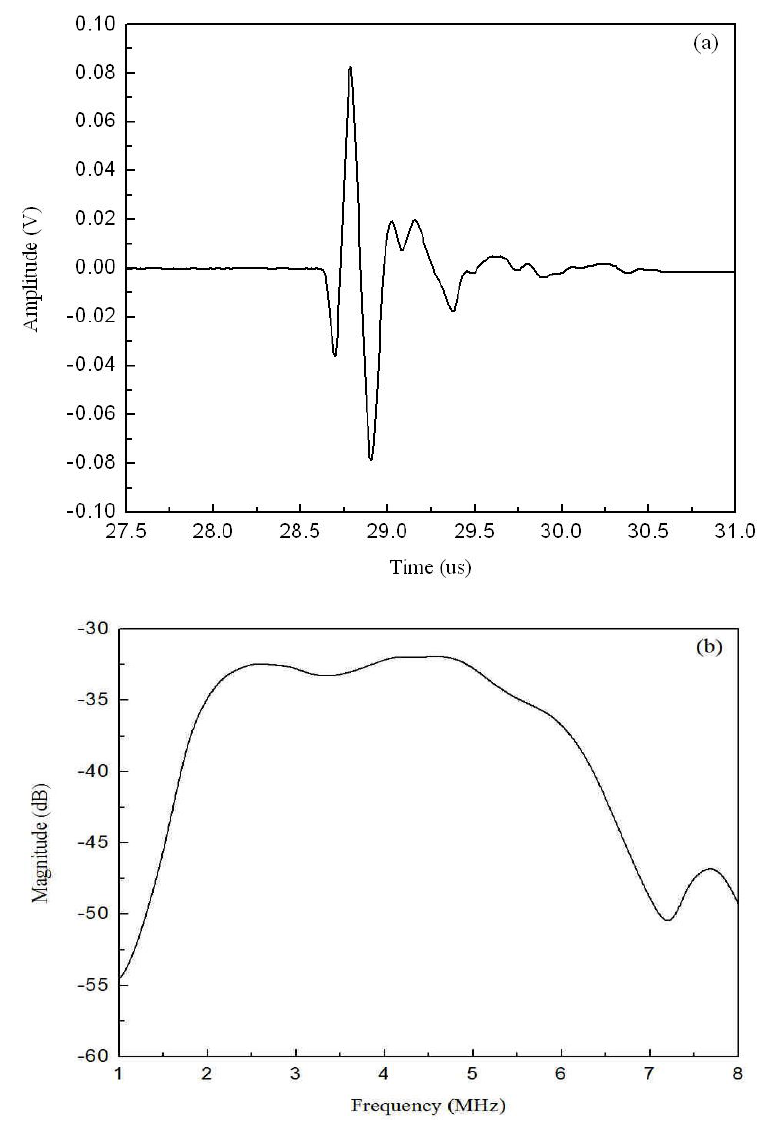
Figure 17. ( a ) Pulse-echo response and ( b ) frequency spectrum of the phased array (with permission from